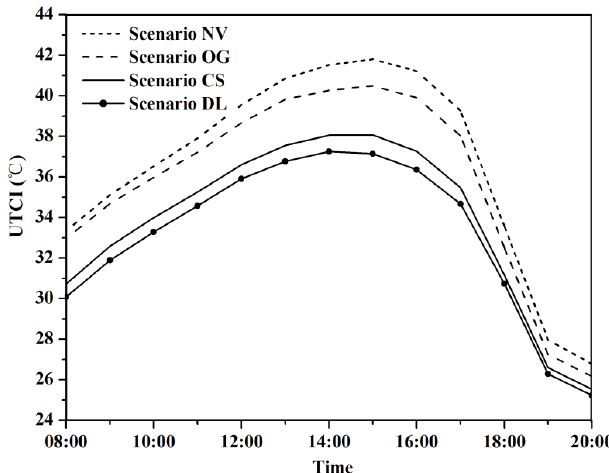
Figure 8. Comparison of average hourly UTCI. NV, OG, CS and DL are short for No Vegetation, Only Grass, Current Situation and Double LAD, respectively.